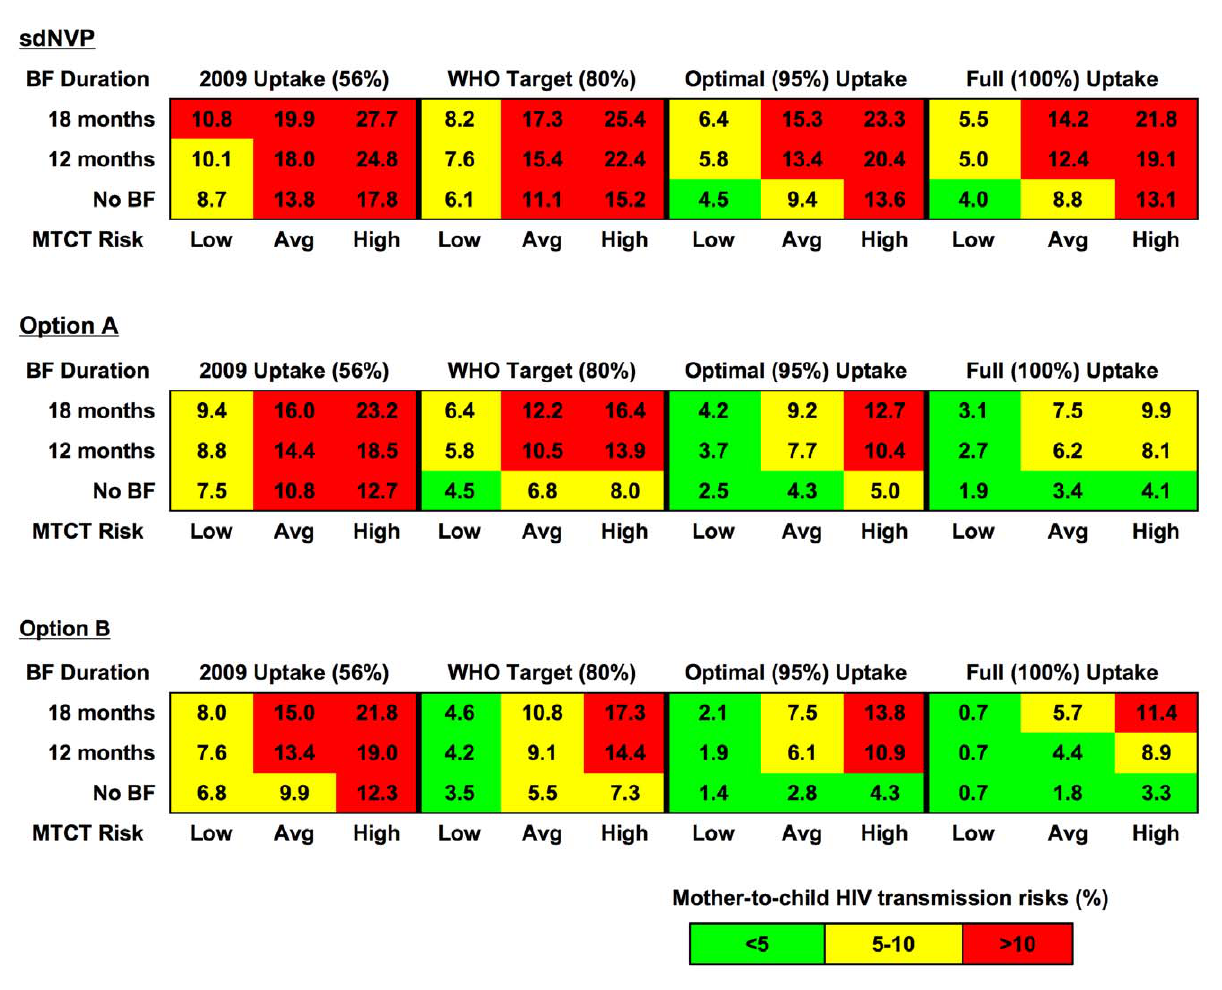
Figure 3. Combinations of parameters needed to achieve MTCT risks , 5%, 5%–10%, and . 10%. Each horizontal block represents results for a specific drug regimen: sdNVP (top), Option A (middle), and Option B (bottom). Within each block, four levels of uptake are depicted across the top horizontal axis: 56% uptake (current estimated uptake in Zimbabwe), 80% uptake (the WHO target), 95% uptake (reported in neighboring Botswana), and 100% uptake (to reflect maximum biologic efficacy of each regimen). The vertical axis illustrates three durations of breastfeeding (BF) for each modeled PMTCT regimen: 18 mo (median in Zimbabwe), 12 mo (concordant with 2010 WHO infant feeding guidelines), and no breastfeeding; ARV prophylaxis in the Option A and Option B regimens is assumed to continue throughout the duration of breastfeeding. The lower horizontal axis shows three categories of published MTCT risks for each drug regimen, including the lowest published risks, the average of published risks (the base-case parameters), and the highest published risks. The percentage in each cell reflects the MTCT risk associated with each set of parameters, and cells are color-coded to reflect broad categories of transmission. Red-colored cells indicate MTCT risks . 10%, yellow-colored cells indicate MTCT risks between 5% and 10%, and green-colored cells indicate MTCT risks ,